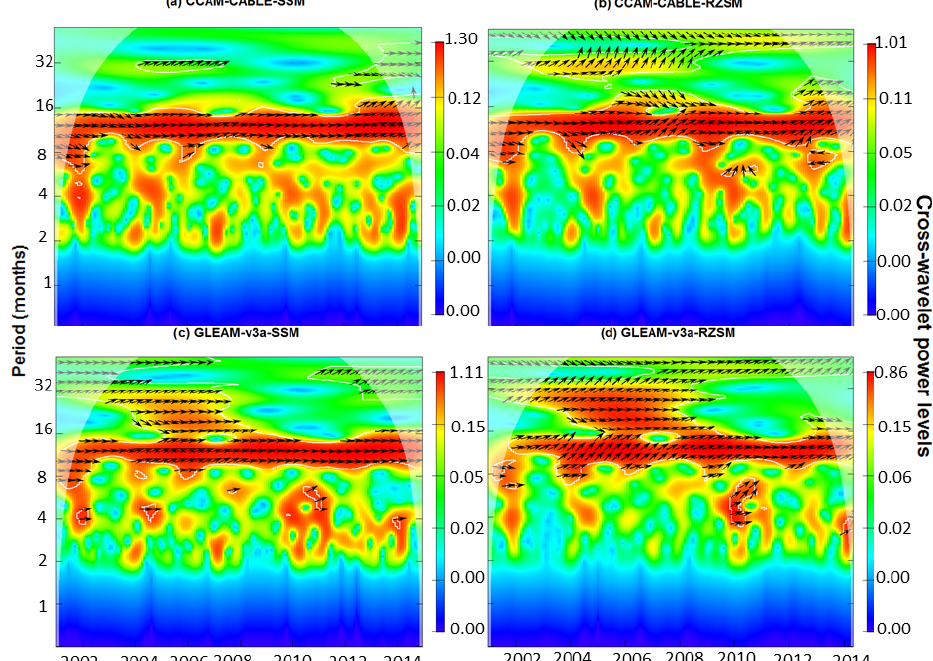
Figure 5. Cross-wavelet power spectrum of surface (SSM, 0–10cm) and root-zone (RZSM, 10–100cm) soil moisture between in situ observations, CCAM-CABLE (a, b) and GLEAM v3a (c, d) at Skukuza respectively. The white contour lines indicate periods of significance at 10%. The arrows pointing to the right indicate that the models and in situ observation are in phase while arrows pointing left reflect that the models are anti-phase. The case where in situ observations are leading either CCAM-CABLE or GLEAM v3a is indicated by arrows pointing straight down. The dome shape (shaded areas) represents the cone of influence between 2001 and 2014. The red colour indicates weak variation while blue indicates the strong variation between the respective time